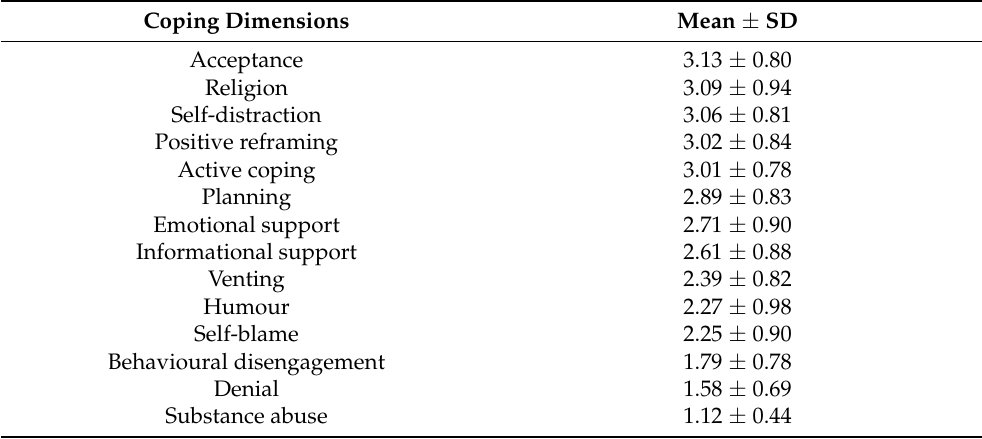
Table 3. Measures of the coping dimensions implemented.